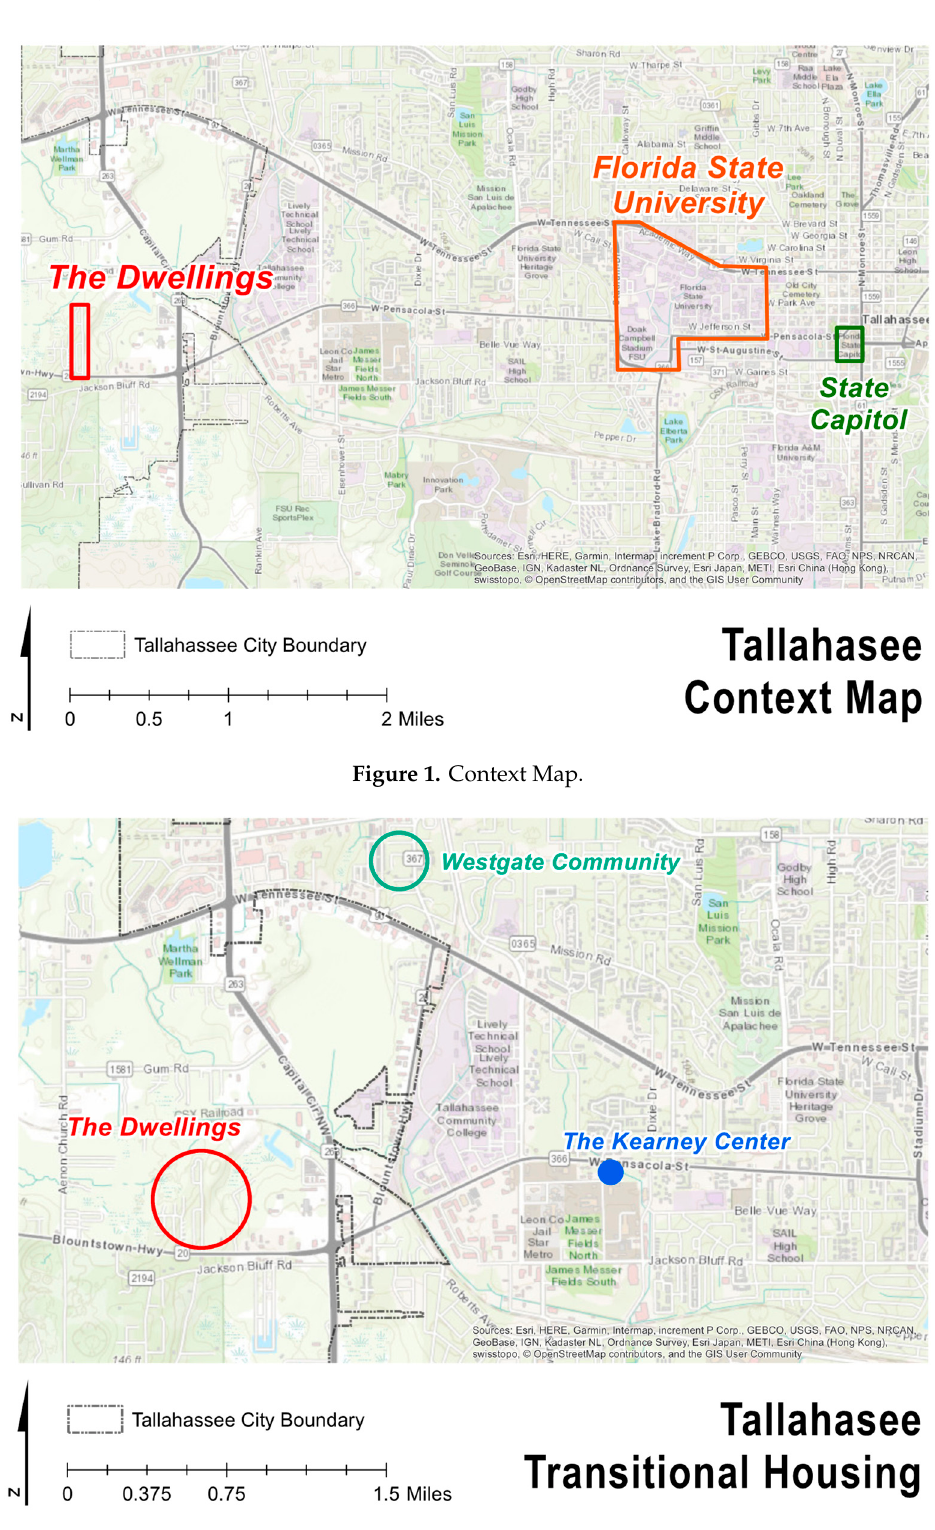
Figure 2. Connecting Everyone to Second Chances (CESC) transitional housing locations.